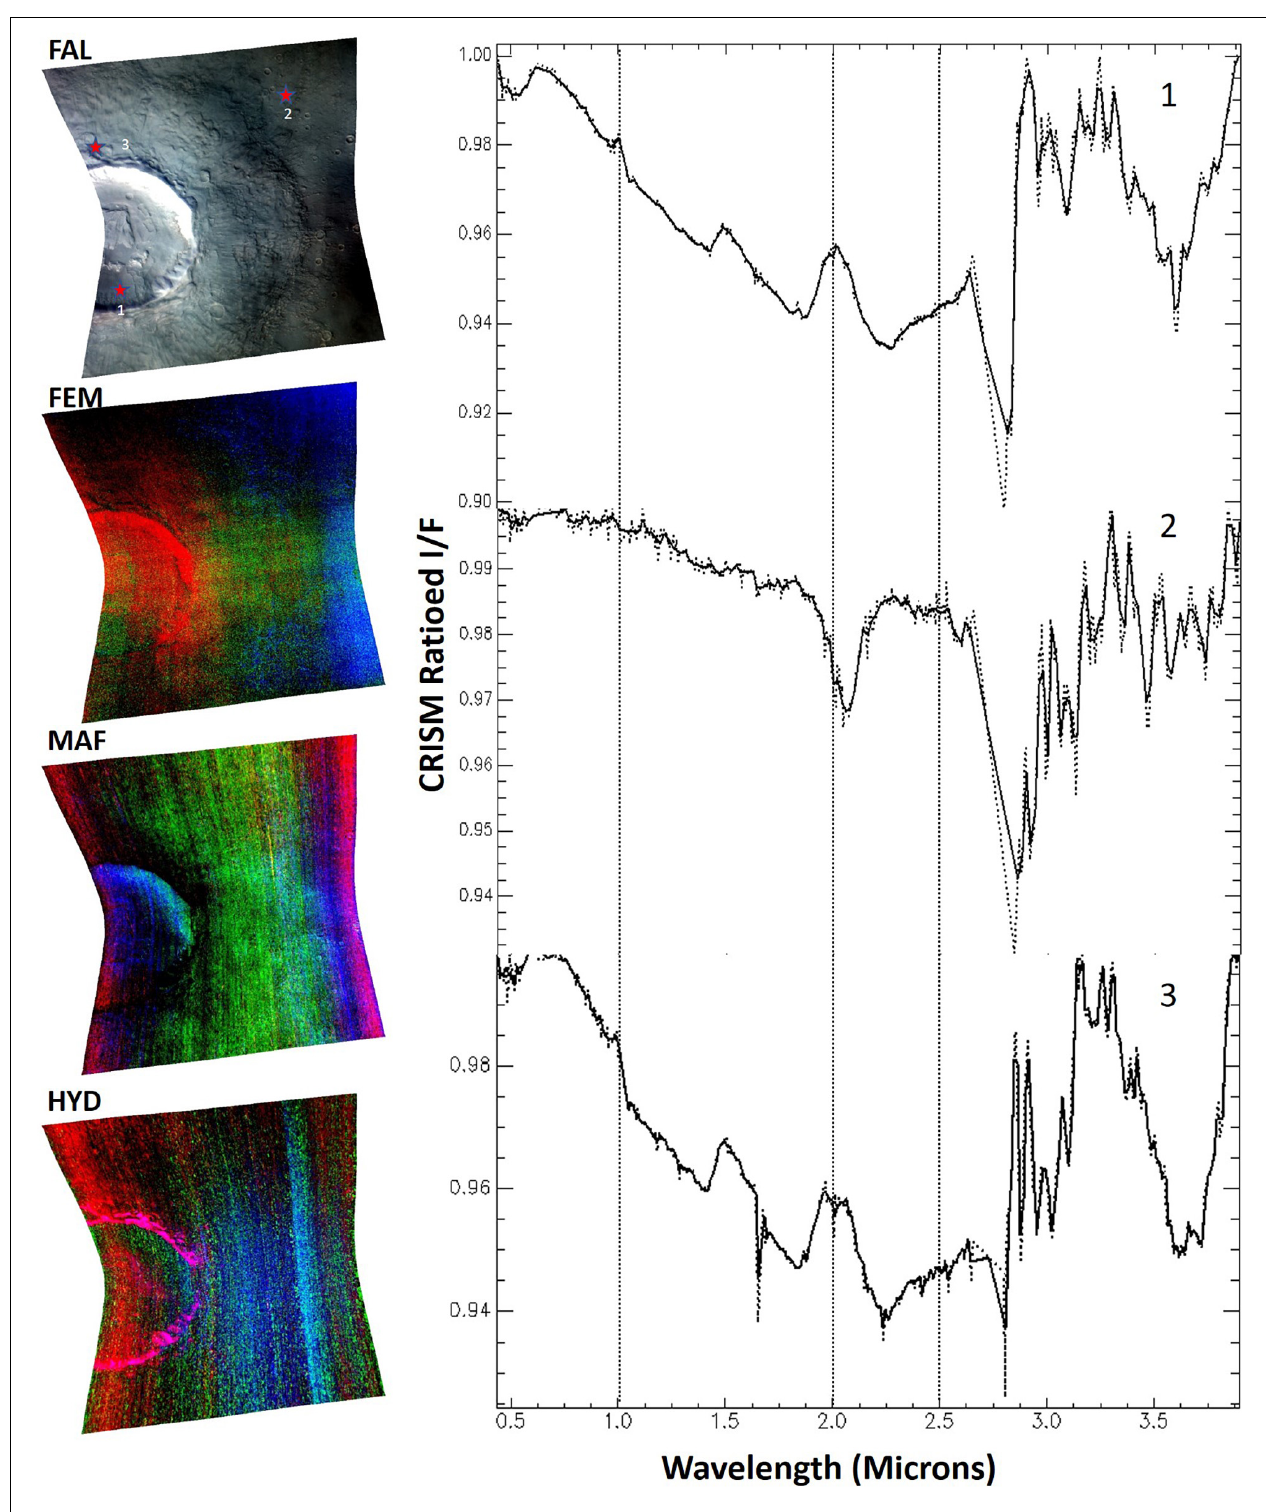
FIGURE 9 | FAL, FEM, MAF, and HYD browse products derived from CRISM data to correlate the map to the surface feature and to assess information regarding ferric and ferrous minerals, primary mafic minerals, and aqueous bounded minerals, respectively. Sample locations are representatively marked in the FAL browse product along with the extracted spectra in Amazonian unit Unnamed crater